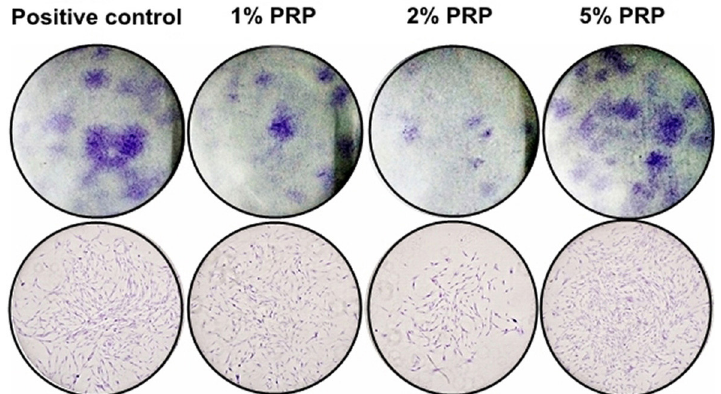
Figure 3- Clonogenic assay at day 14 (Upper line: observed by naked eye. Lower line: observed by microscope with 4x magnification)